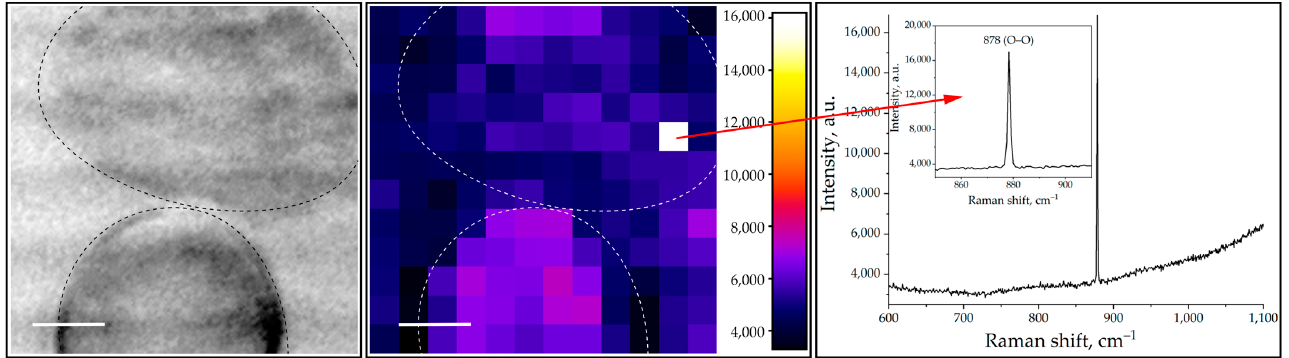
Figure 1. Micrograph ( left ), Raman map ( middle ), and spectrum ( right ) of neutrophils exposed to radiation with a wavelength of 625 nm and a dose of 32 J/cm 2 . The characteristic sharp lines of H 2 O 2 can be seen on the right. The spectral gate was aligned within the interval of 872–882 cm − 1 with excitation at 632.8 nm. Scan area 24 × 24 µm, bars: 5 µm.